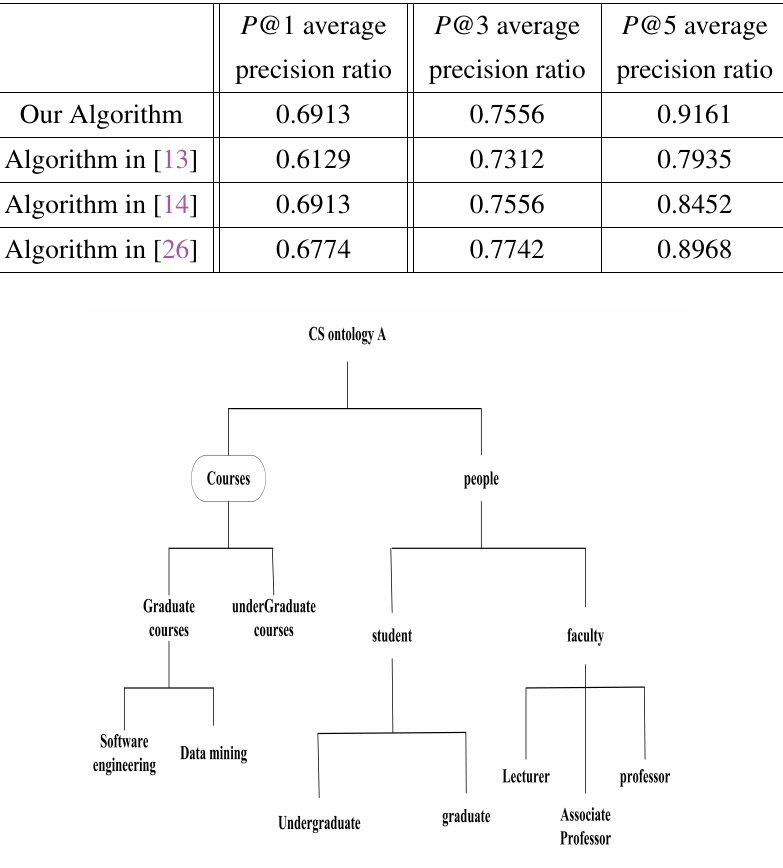
Table 4 Tab. 4. The Experiment Results of Ontology Mapping